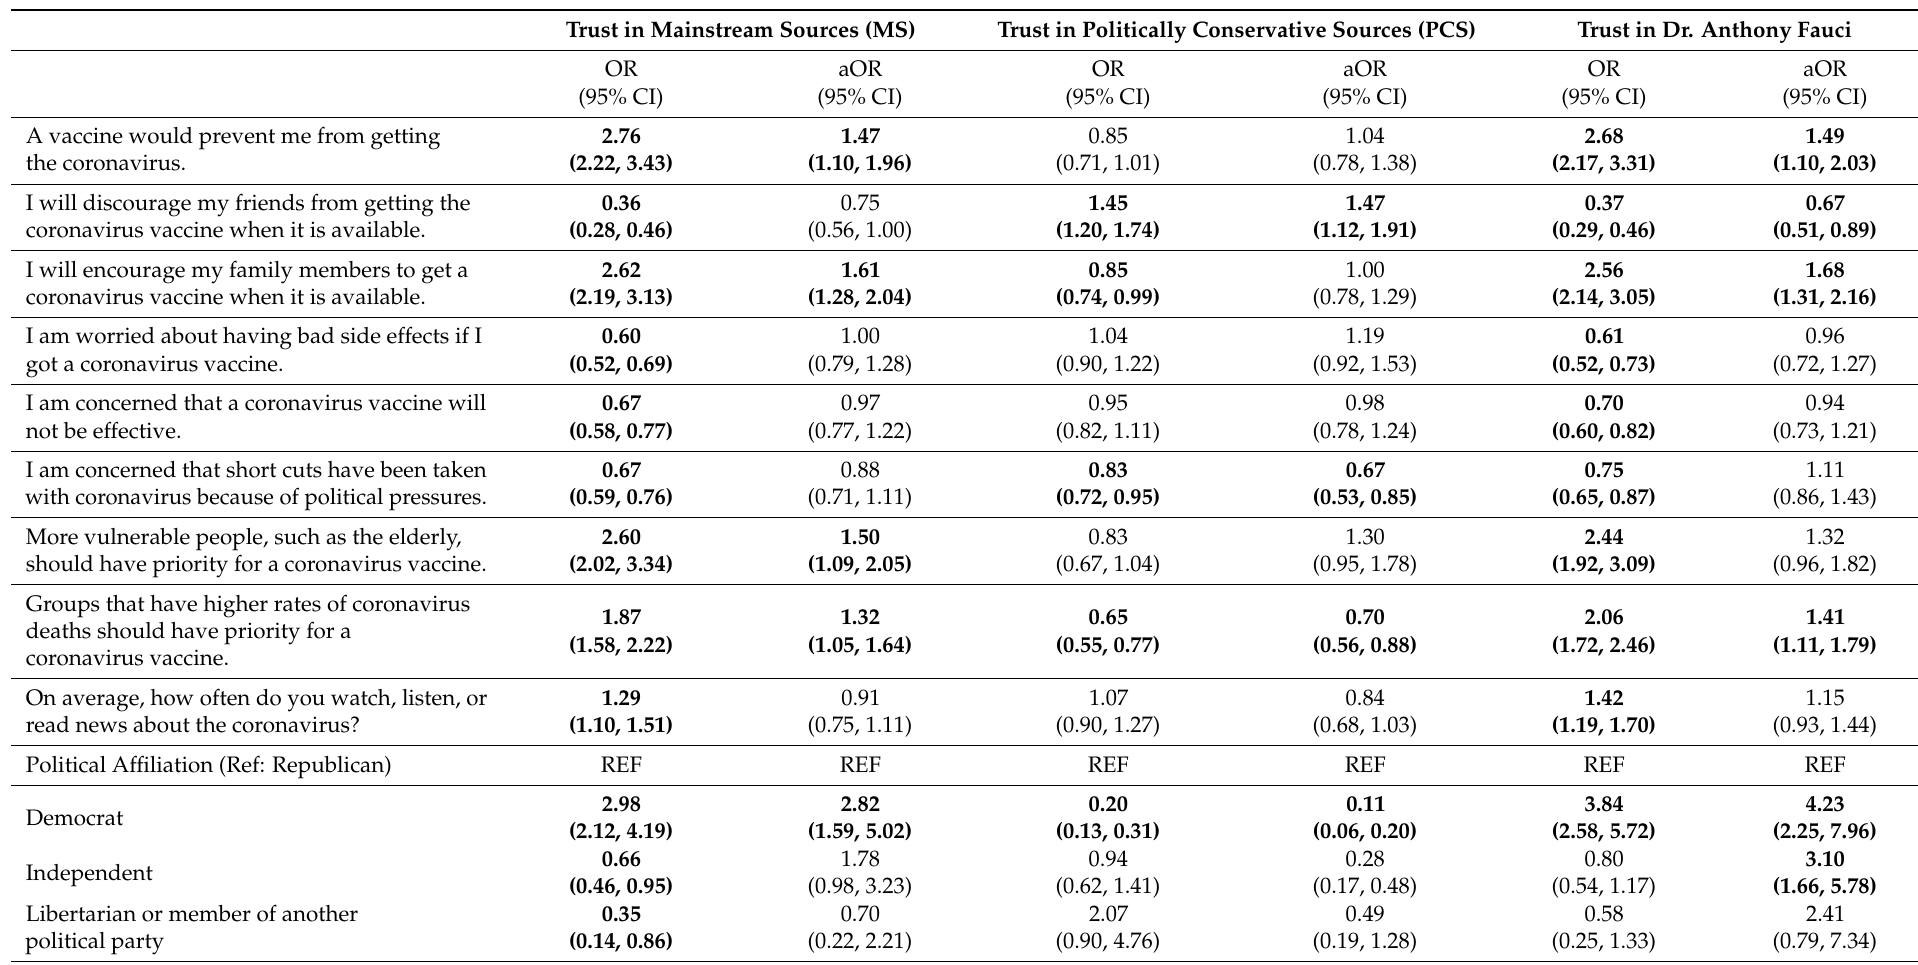
Table 6. Multiple logistic regression models with binary outcome measures of trusted information sources among study participants in the US, 2020 ( N = 585). Trust in Mainstream Sources (MS) Trust in Politically Conservative Sources